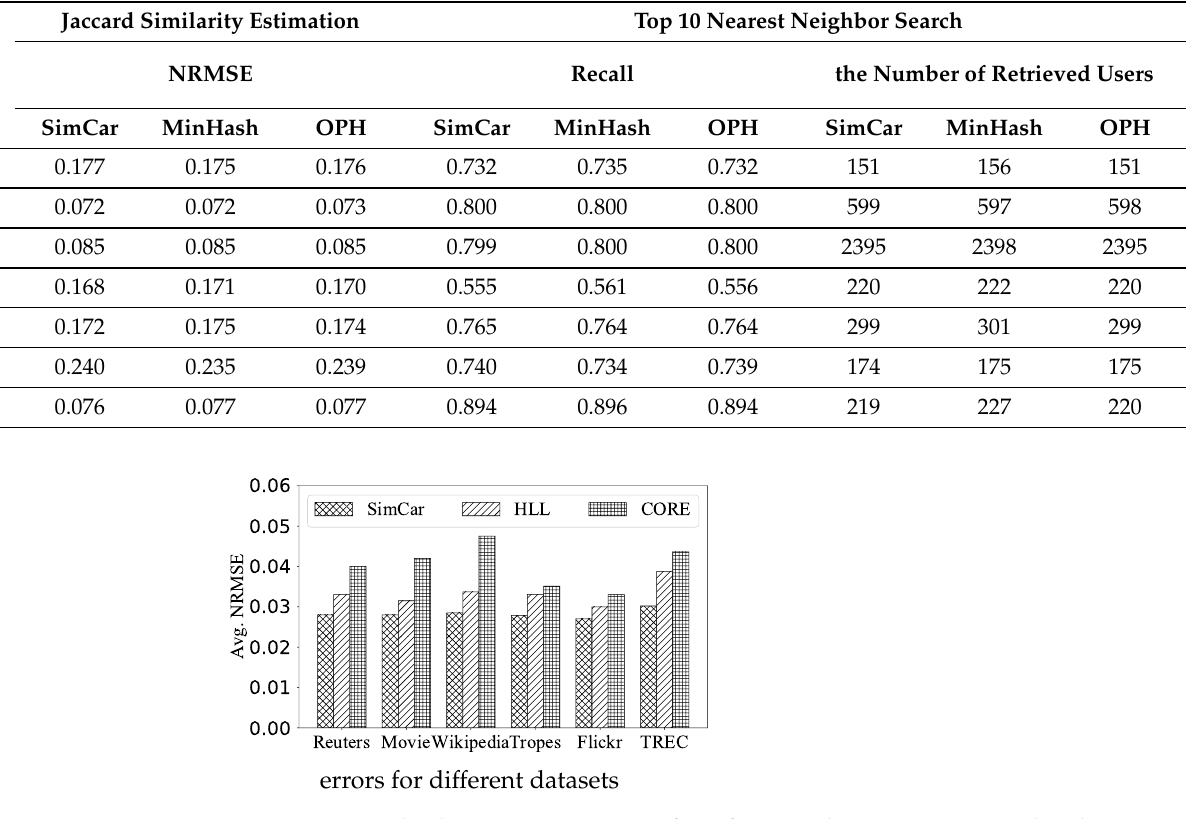
Figure 3. User cardinality estimation errors of our framework, SimCar, compared with HLL and CORE, k 1 = k = 2 9 by default.